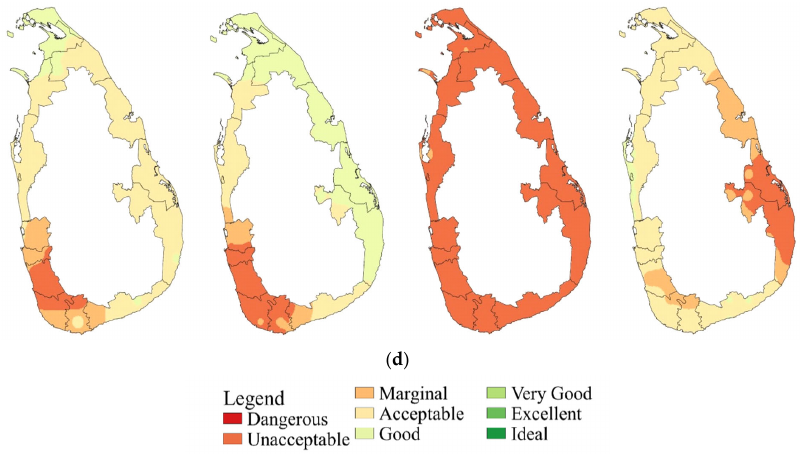
Figure 6. Spatial distribution of HCI Beach score under RCPs: ( a ) For RCP4.5 2021–2050; ( b ) For RCP4.5 2071–2100; ( c ) For RCP8.5 2021–2050; ( d ) For RCP8.5 2071–2100.